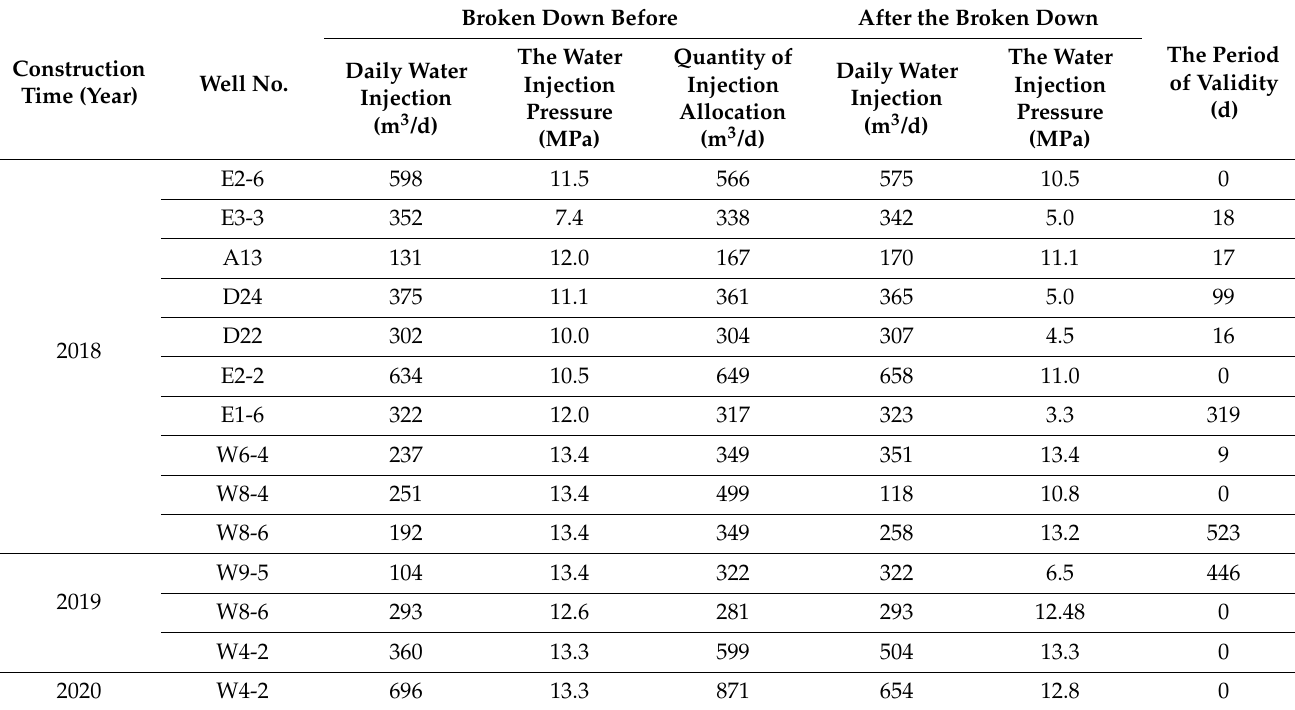
Table 5. Plugging effect statistics of injection Wells.